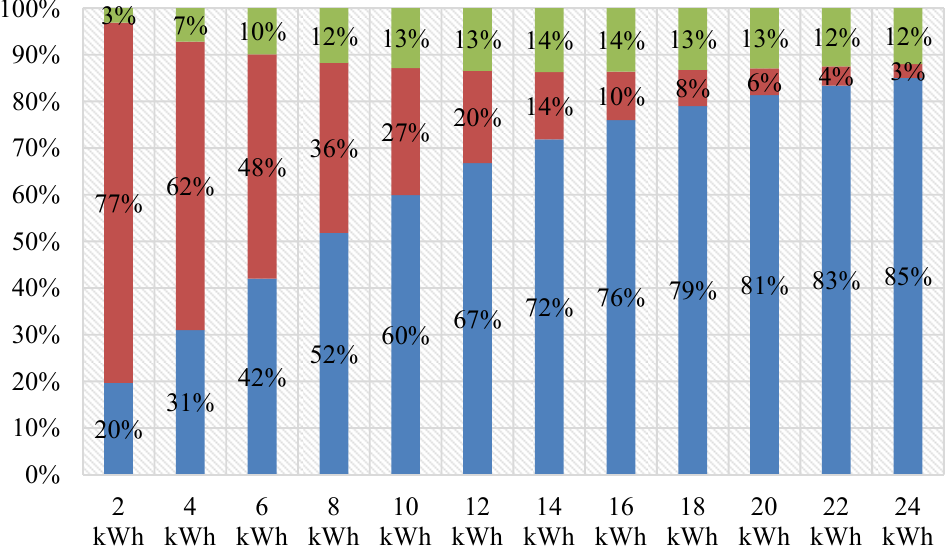
Figure 6. Sub-cost